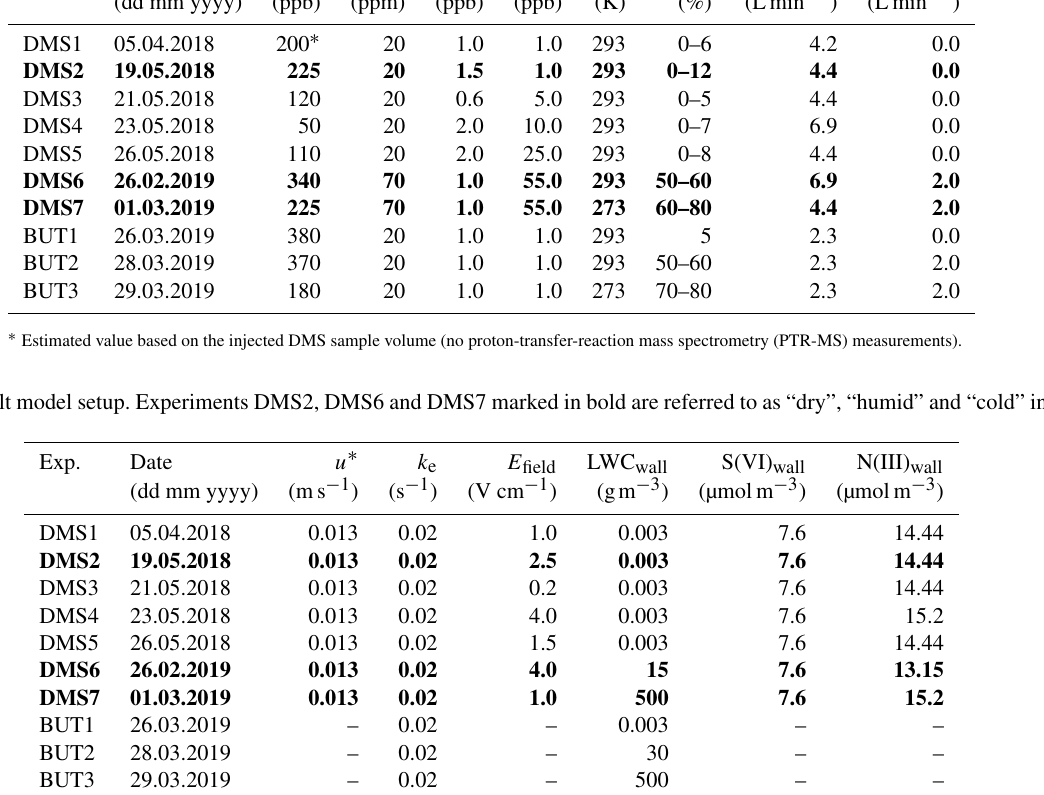
Table 1. Experimental (model) conditions. Experiments DMS2, DMS6 and DMS7 marked in bold are referred to as “dry”, “humid” and “cold” in Sect. 3. Experiments DMS1-5 and BUT-1 are described in detail in Rosati et al. (2021b), and experimental data for these experiments are adopted from Rosati et al. (2021b). Exp.